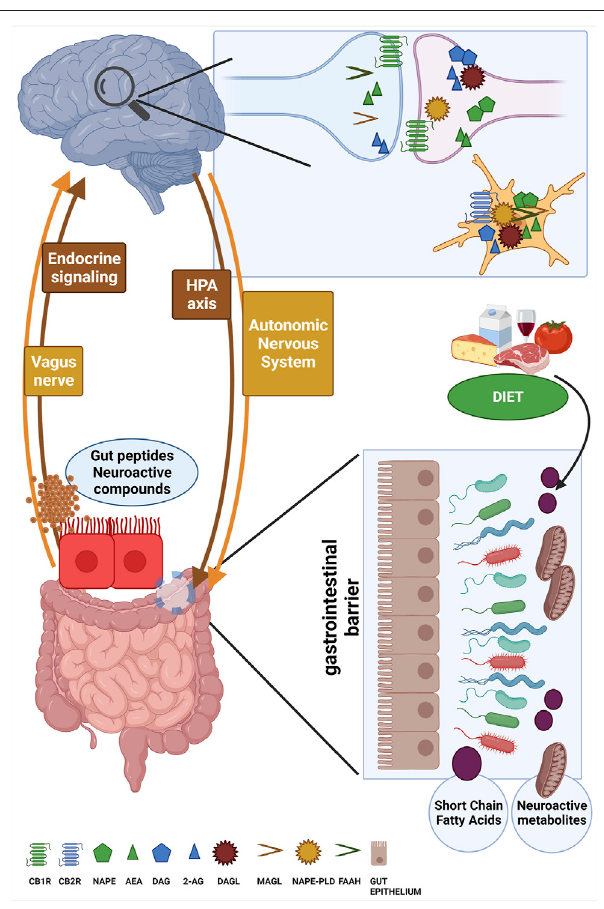
FIGURE 1 | The fi gure schematizes the bi-directional and reciprocal in fl uence between brain and gut (i.e., the gut-brain axis) along the main routes of communication such as the HPA axis, the autonomic nervous system, the vagus nerve and endocrine signaling. The ability to sense microbiota metabolites, gut peptides and neuroactive compounds and to transfer to the brain this complex information about the ongoing status of gut microbial ecosystem is fundamental for the generation of adaptive or maladaptive responses,for instance bytheHPA axis and cortisol secretion. Here,the main components of the eCB system machinery are depicted at both presynaptic and postsynaptic terminals as well as in microglia cells, and the attention is focusedontheroleofpowerfulexternalmodi fi erssuchasdietarycomposition to mutually affect gut microbiota composition and eCB signaling. created in